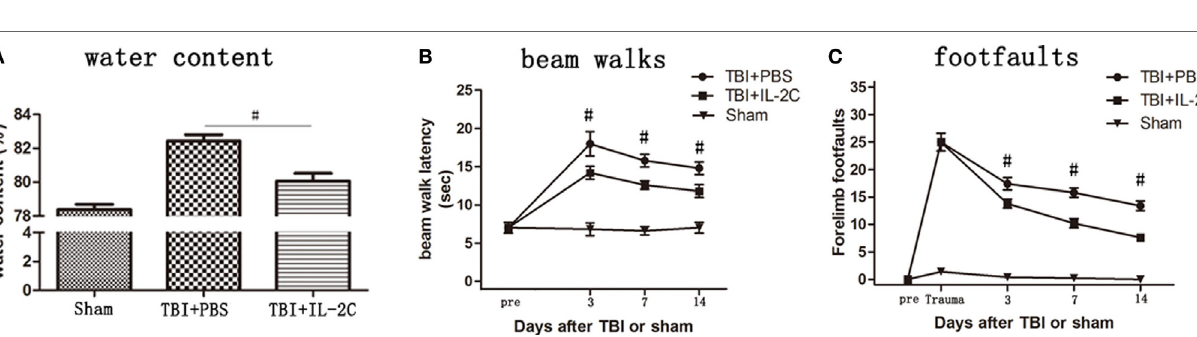
FigUre 6 | (a) The brain water content of the ipsilateral hemisphere was measured at 72 h after injury. Brain water content was significantly higher in the control than in the sham group, whereas treatment with IL-2C significantly reduced brain water content ( n = 5 mice/group). (B) Treatment with IL-2C significantly improved the beam walking speed compared with the PBS group, measured until 14 days after traumatic brain injury (TBI). (c) IL-2C treatment significantly reduced the number of forelimb foot faults from day 3 after TBI ( n = 5 mice/group). Data are presented as the mean ± SD; * p < 0.05 and # p <